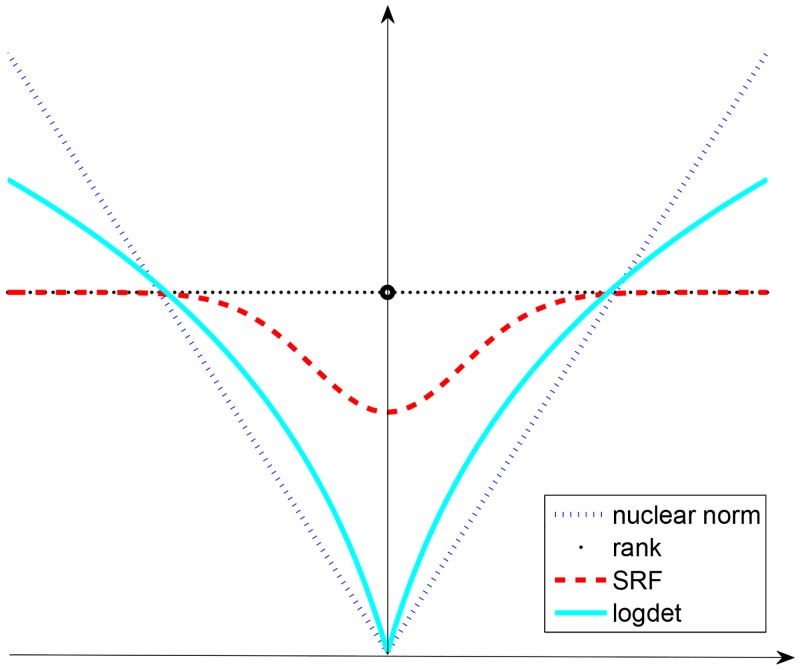
Performance of SRF = Gδ(x), rank = ||x||0, the nuclear norm = ||x||1 and logdet = log(|x|+ε) in the case of a scalar, where δ = 1 and ε = 1.